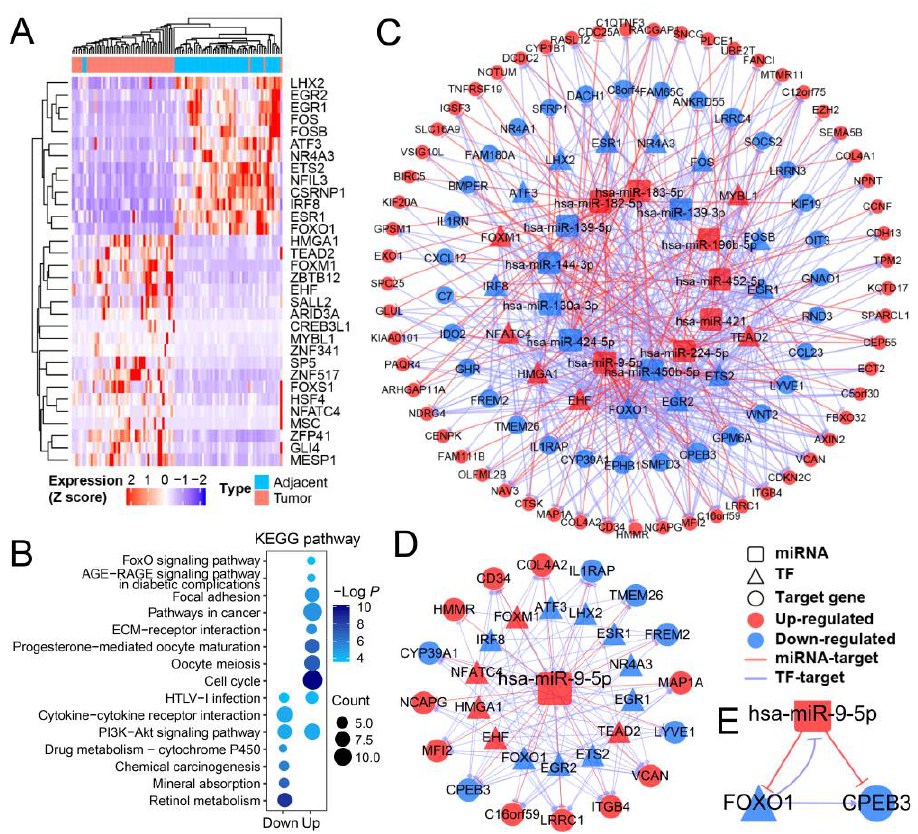
Figure 1. The miRNA–TF gene regulatory network and hub nodes in HCC. ( A ) Heatmap for differentially expressed TFs in HCC tumor vs. adjacent tissues. The color gradient from blue to red indicates the scaled expression (Z score) from low to high. ( B ) Result of KEGG pathway enrichment analysis for differentially expressed genes (DEGs). ( C ) miRNA–TF–gene FFL regulatory network for all DEGs and differentially expressed miRNAs (DEMs). TFs, miRNAs and their target gene(s) are indicated in triangles, rounded rectangles and circles, respectively. Genes upregulated and down-regulated in all patient tumor samples are indicated in red and blue, respectively. Purple edges indicate TF–target regulation, while red edges indicate miRNA–target regulation. ( D ) The miR-9-5p–TF gene regulatory network. ( E ) The miR-9-5p–FOXO1–CPEB3